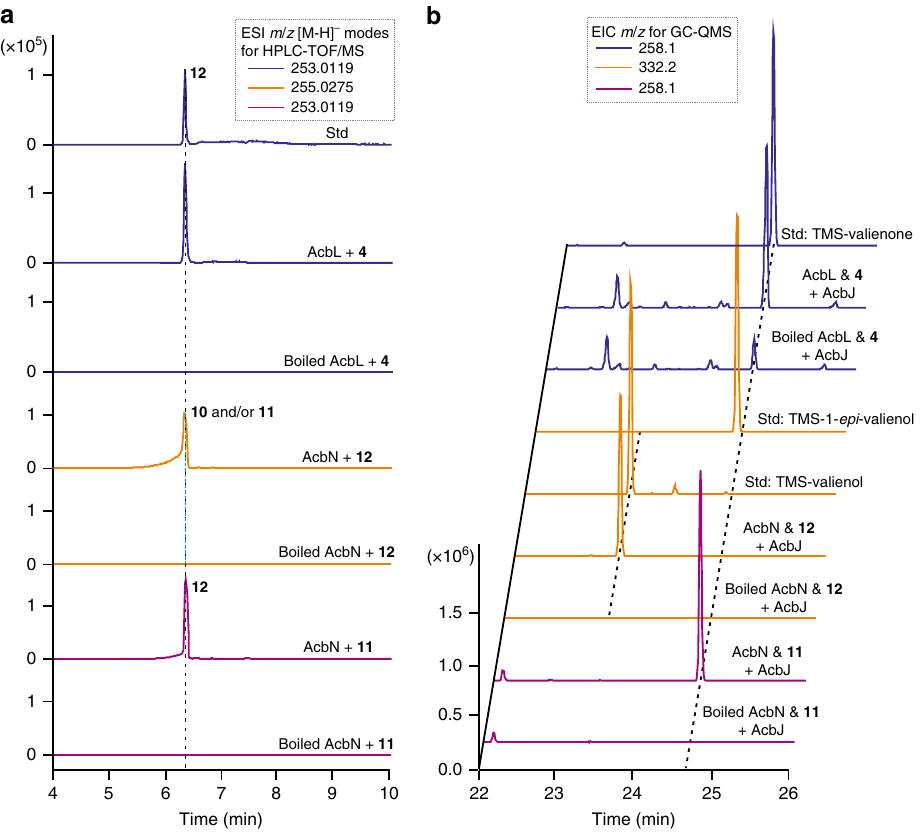
Fig. 4 Further clari fi cation of the C 7 -cyclitol moiety biosynthetic pathway by characterizing AcbL- and AcbN-catalyzed conversions. a HPLC-TOF/MS analysis of the standard (std) of 12 and the reaction products of AcbL with 4 , boiled AcbL with 4 , AcbN with 12 , boiled AcbN with 12 , AcbN with 11 , and boiled AcbN with 11 . All the chromatograms show the extraction of corresponding calculated ions. b GC-QMS con fi rmation of the reaction products after dephosphorylation by AcbJ. AcbJ was added to the reaction products of AcbL & 4 , boiled AcbL & 4 , AcbN & 12 , boiled AcbN & 12 , AcbN & 11 , and boiled AcbN & 11 . The standards (std) 13 , 8 , and 9 were also analyzed by GC-QMS after derivatization by BSTFA. All the chromatograms show the extraction of corresponding unique product ions. TMS is the abbreviation of trimethyl silicyl. For more details, see also Supplementary Figs. 11, 23. Source data are provided as a Source Data fi